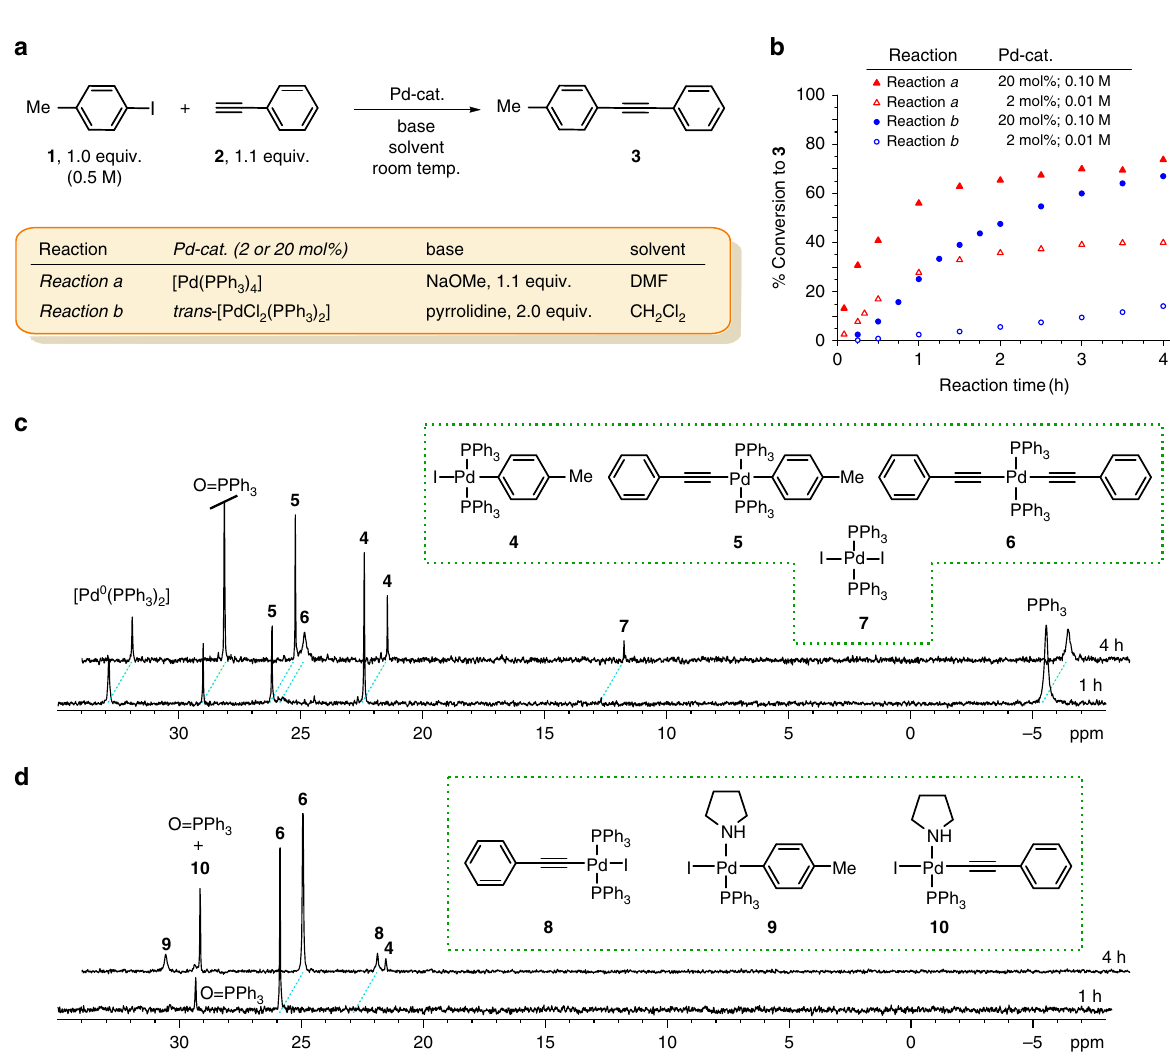
Fig. 2 Model reactions and conditions with the proposed phosphorous containing species. a , b Reaction conditions ( a ) and product 3 build-up as determined by 1 H NMR spectroscopy ( b ). c 31 P NMR spectra of aliquots from Reaction a (with 20 mol% of Pd-cat.), after 1 and 4 h. d 31 P NMR spectra of aliquots from Reaction b (with 20 mol% of Pd-cat.), after 1 and 4 h. Relative intensities of the resonances do not correspond to the concentrations of the species. For spectra showing more frequent sampling, see Supplementary Figs. 1 –